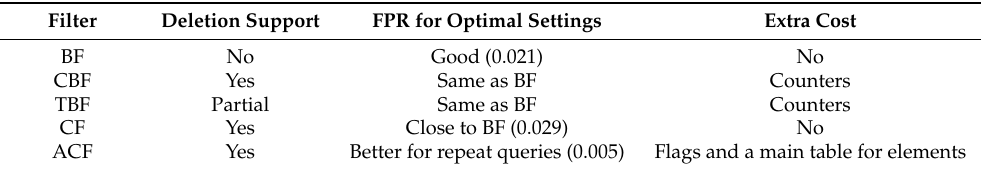
Table 1. Comparison of several